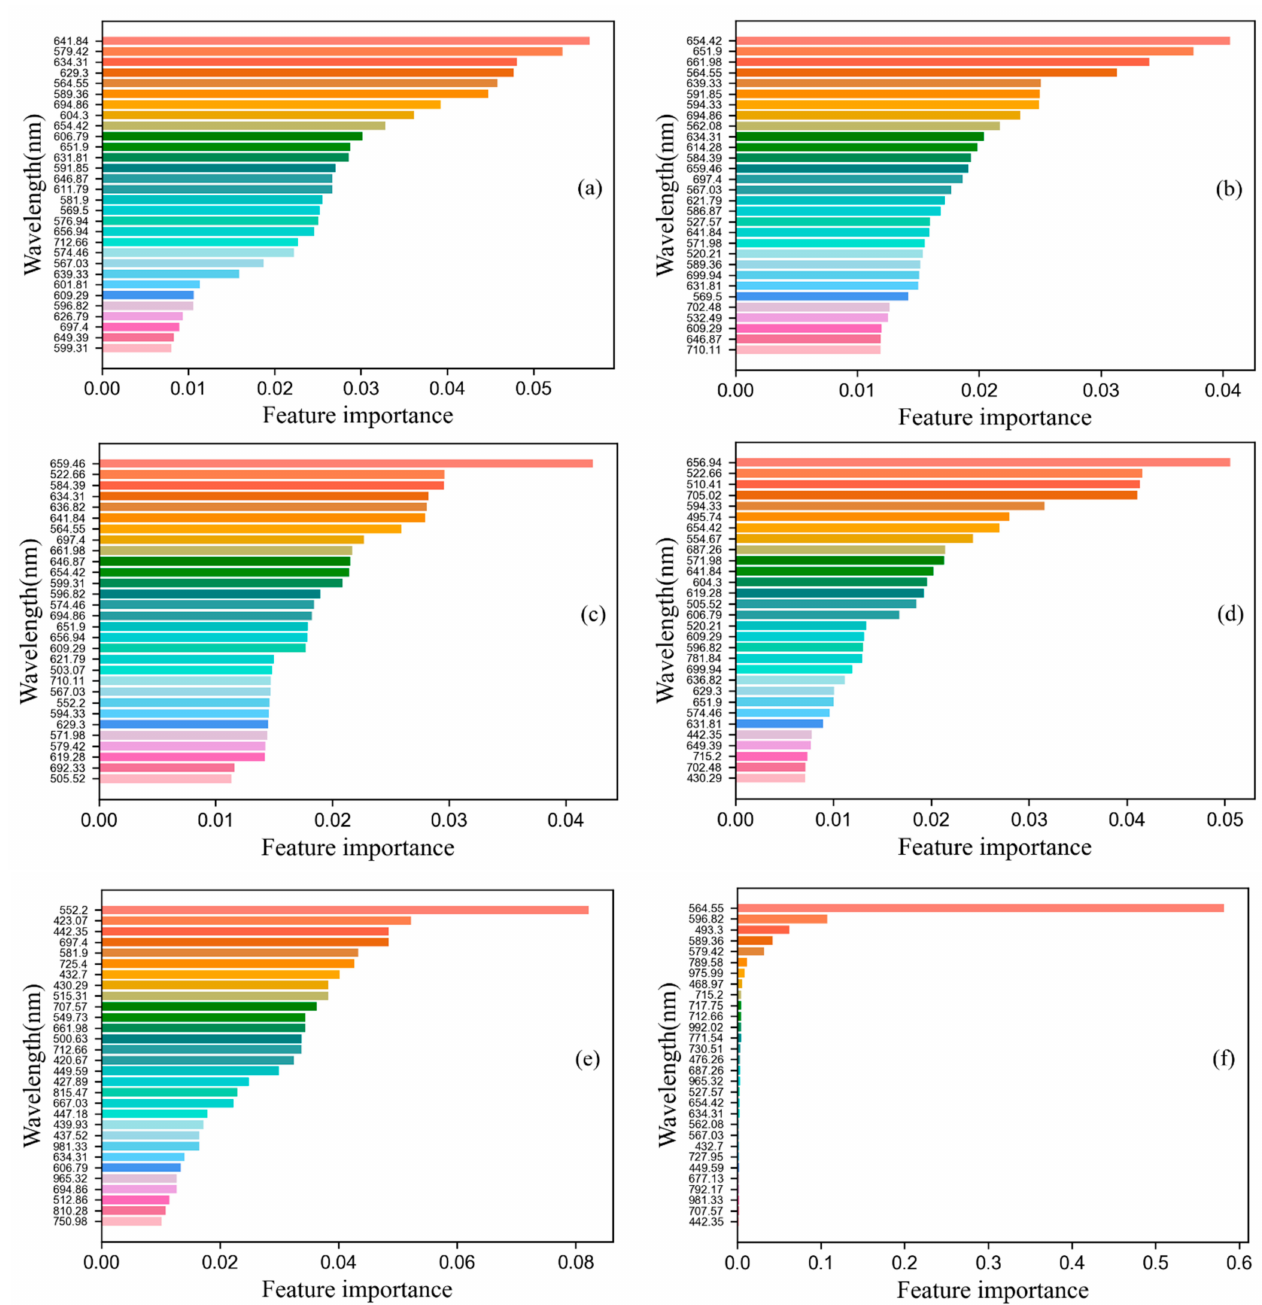
Figure 5. Feature bands selected by different algorithms. ( a ) GB; ( b ) AdaBoost; ( c ) RF; ( d ) CatBoost; ( e ) LightGBM and ( f )